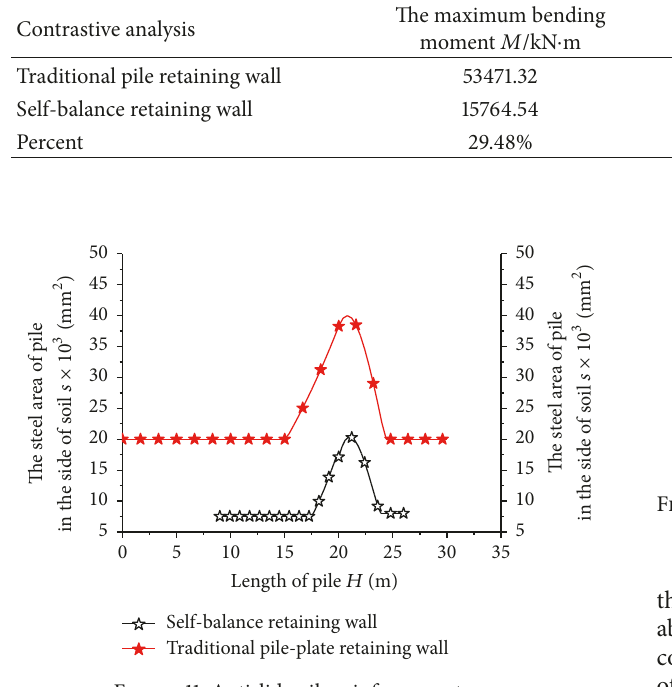
Figure 11: Antislide pile reinforcement area.